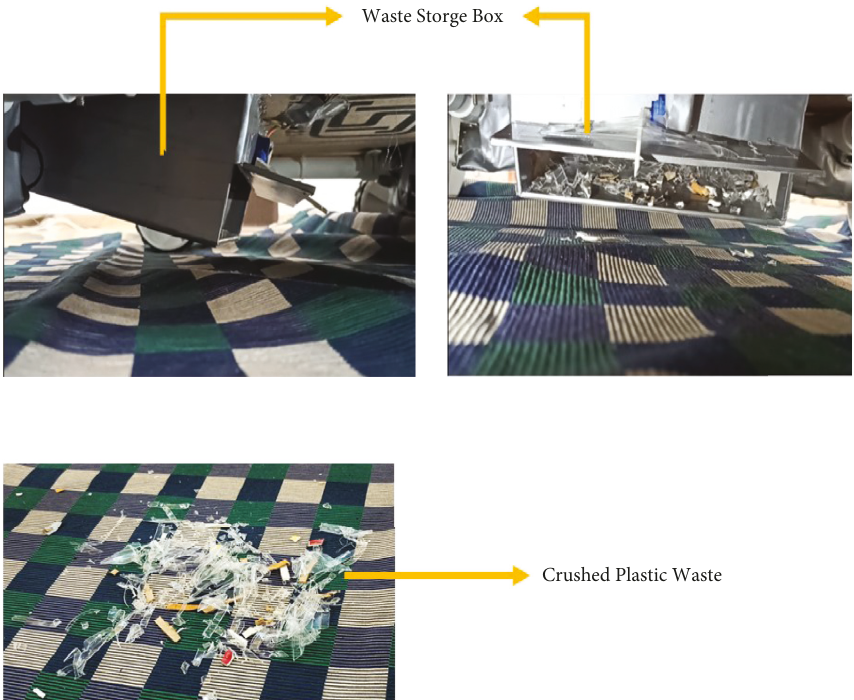
Figure 9: Sample of crushed